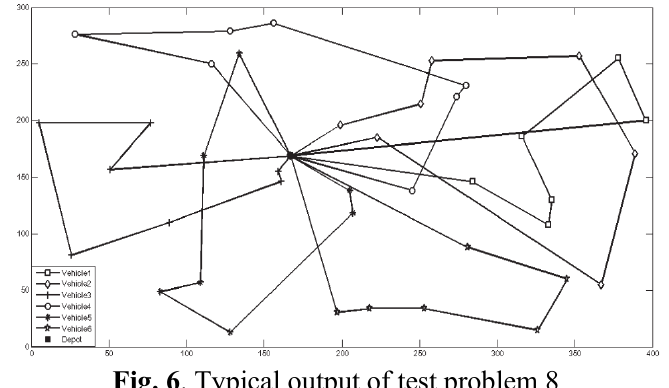
Fig. 6 . Typical output of test problem 8